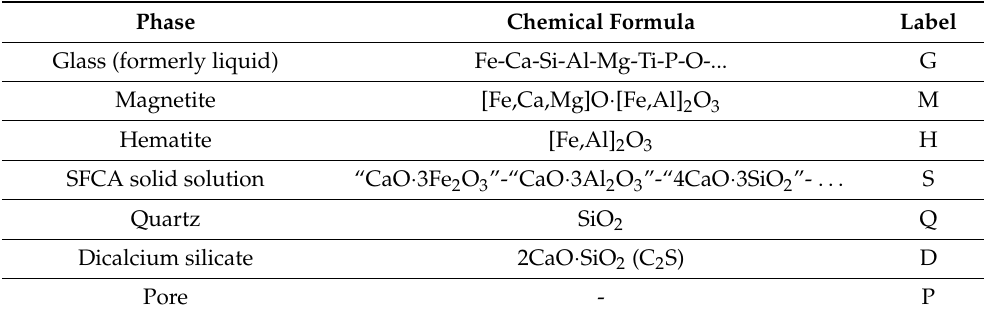
Figure 3. Four main microstructural types I~IV in the sinter samples, ( a ) Micro-Type I; ( b ) Micro-Type II; ( c ) Micro-Type-III; ( d ) zoomed details of Micro-Type II; ( e ) Micro-Type IV; and ( f ) zoomed details of Micro-Type IV, G = Glass; H = Hematite; M = Magnetite; S = SFCA solid solution; D = Dicalcium silicate (C 2 S); P = Pores. Table 2. List of phases identified in sinter samples, their chemical formulae and abbreviations used in this